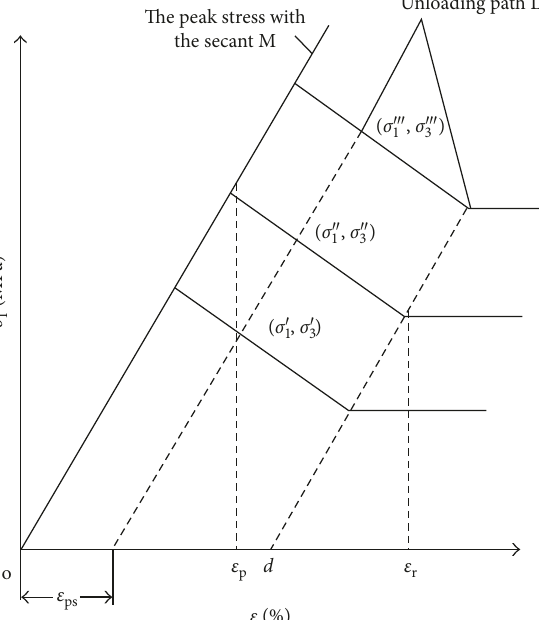
Figure 4: Post-peak strain softening simplified model stress states under the same unloading